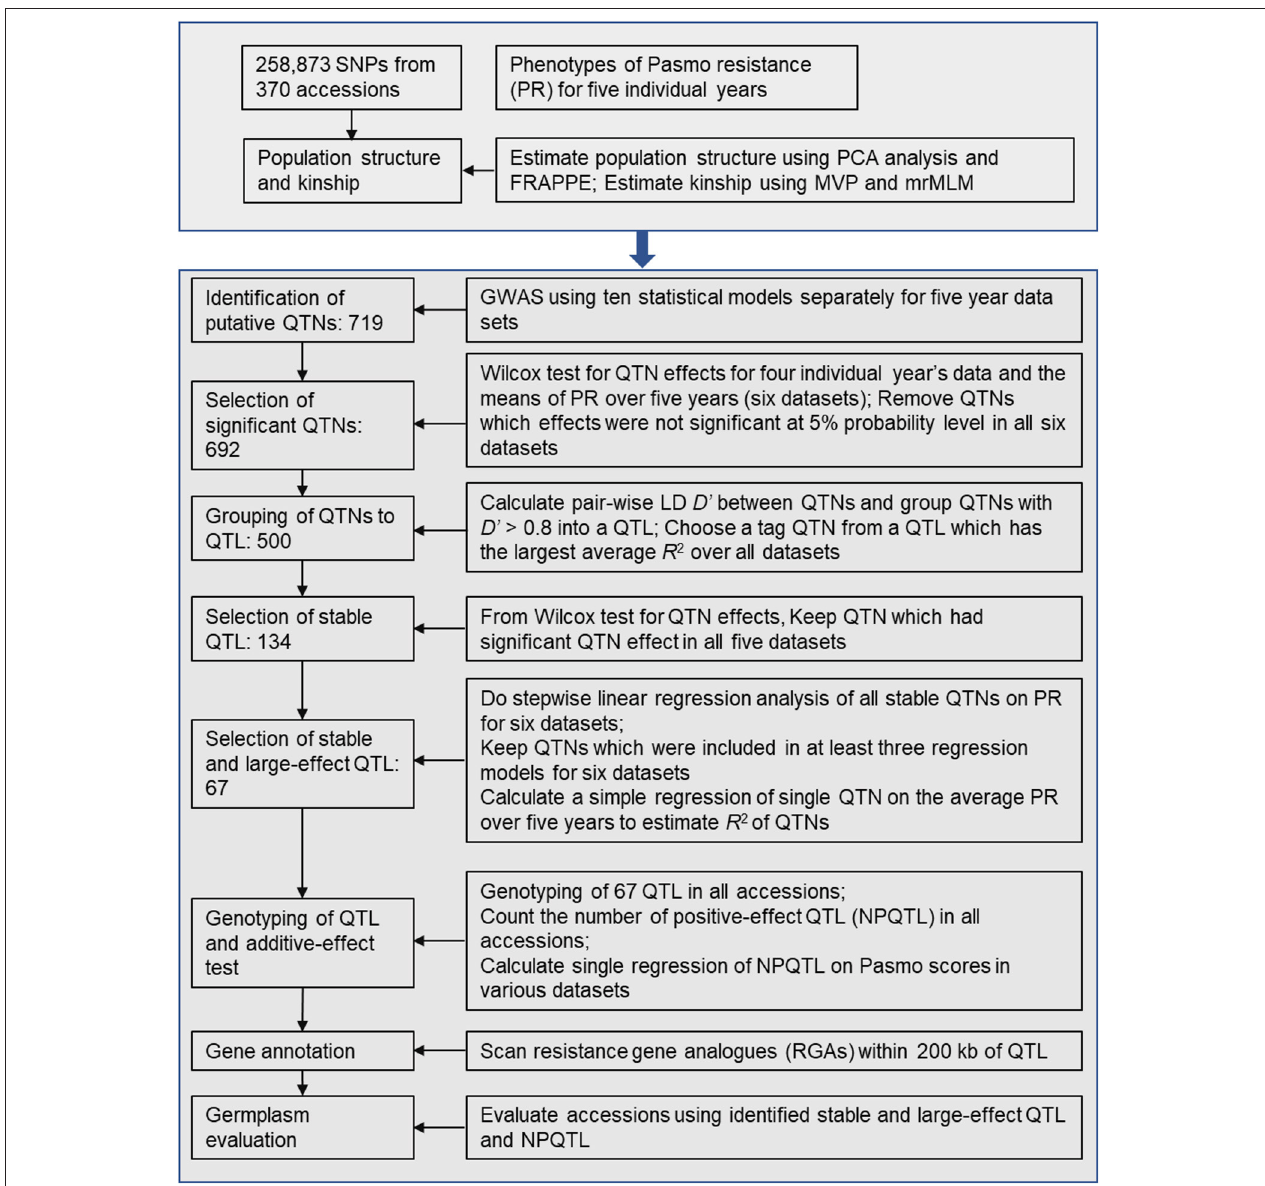
FIGURE 1 | Diagram of stable and large-effect quantitative trait loci (QTL) associated with flax pasmo resistance. NPQTL: the number of QTL with positive-effect alleles.